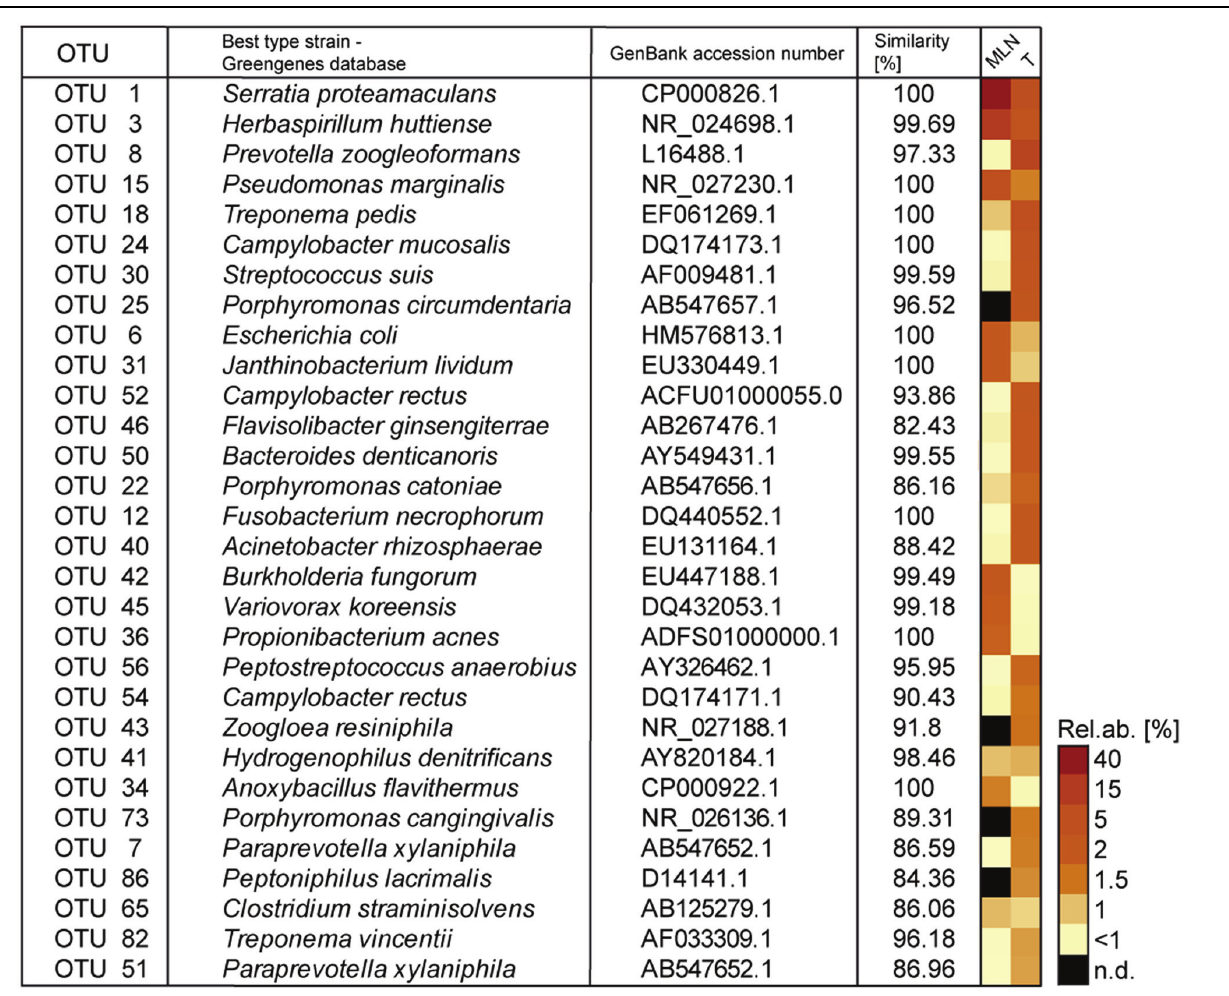
1 dominated (best hits: Prevotella zoogleoformans,